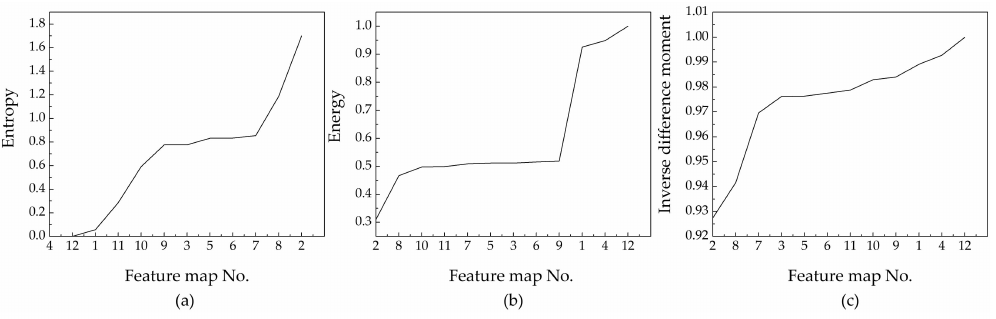
Figure 4. Variation of each indicator.